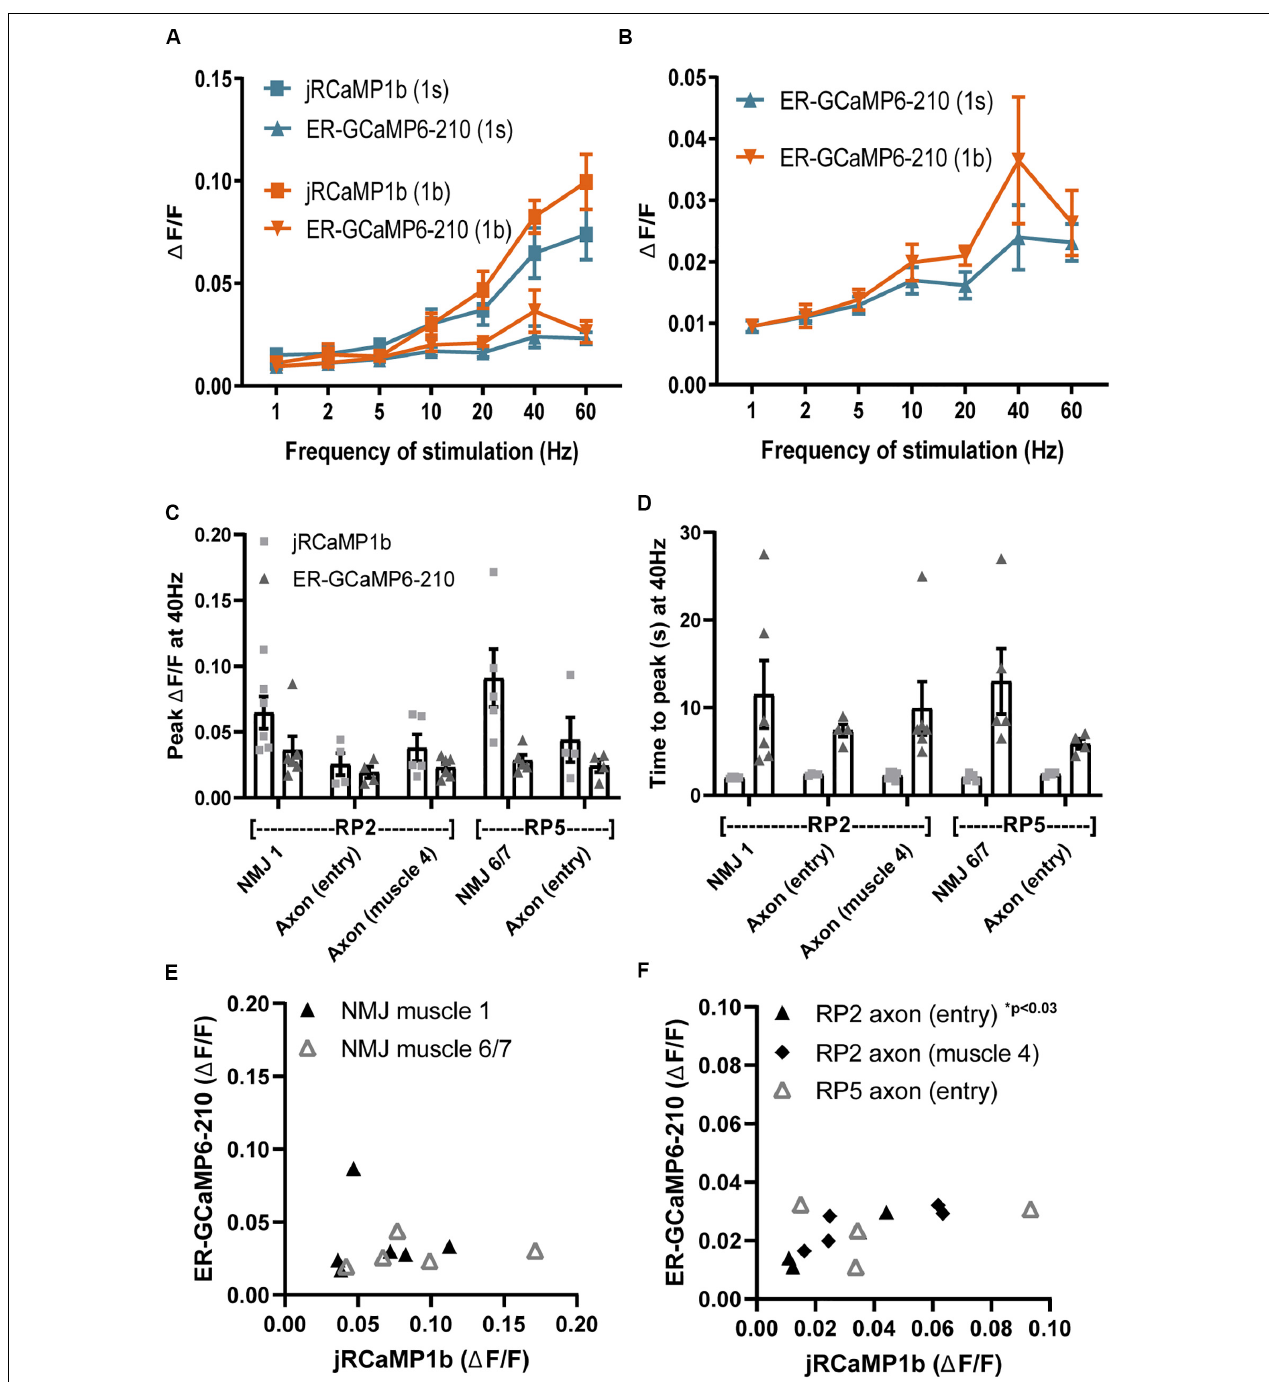
FIGURE 3 | Comparisons of ER lumenal and cytoplasmic Ca 2 + responses across axons and NMJs of Type Ib and Is motor neurons. (A) Evoked responses of lumenal ER-GCAMP6-210 and cytoplasmic jRCaMP1b to a range of stimulation frequencies, in Type Ib boutons of the aCC neuron at the muscle 1 NMJ, expressed using Dpr-GMR94G06-GAL4 ( N = 6), or in Type Is boutons at the muscle 1 NMJ of the RP2 neuron expressed using FMR-GMR27E09-GAL4 ( N = 6). (B) Comparison of ER lumen sensor data only, from (A) but with y -axis expanded. (C) Lumen and cytoplasmic Ca 2 + fluxes at different positions of Type Is neurons RP2 and RP5 ( Supplementary Datasheet 1 ), with sensors expressed using FMR-GMR27E09-GAL4 . (D) The time to peak (cid:49) F / F , for both lumen and cytoplasmic responses, was similar across all axon and NMJ positions. (E,F) Peak amplitudes (from C ) of individual ER lumen and cytoplasm responses were plotted for the NMJ (E) and axonal (F) compartments of RP2 and RP5. A positive correlation was found only for RP2 axon entry but not for other locations ( Table 2 ). One outlier in RP2 axon (muscle 4) jRCaMP1b was excluded from graphs (C) and (F) (value 0.29), but included in analysis in (F)